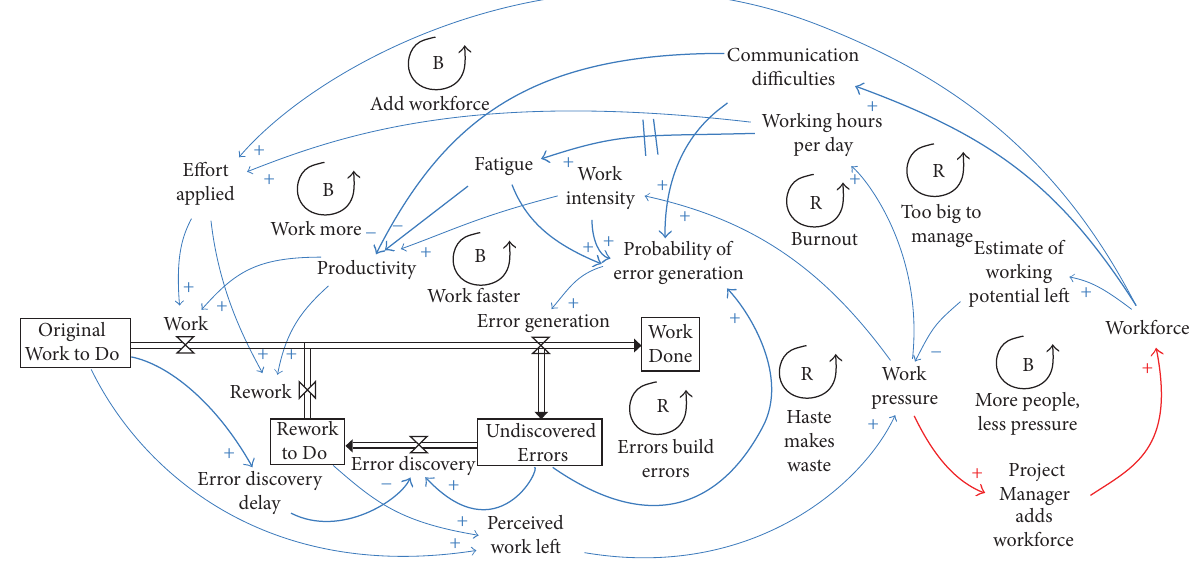
Figure 4: Rework cycle 3/3: the reinforcing